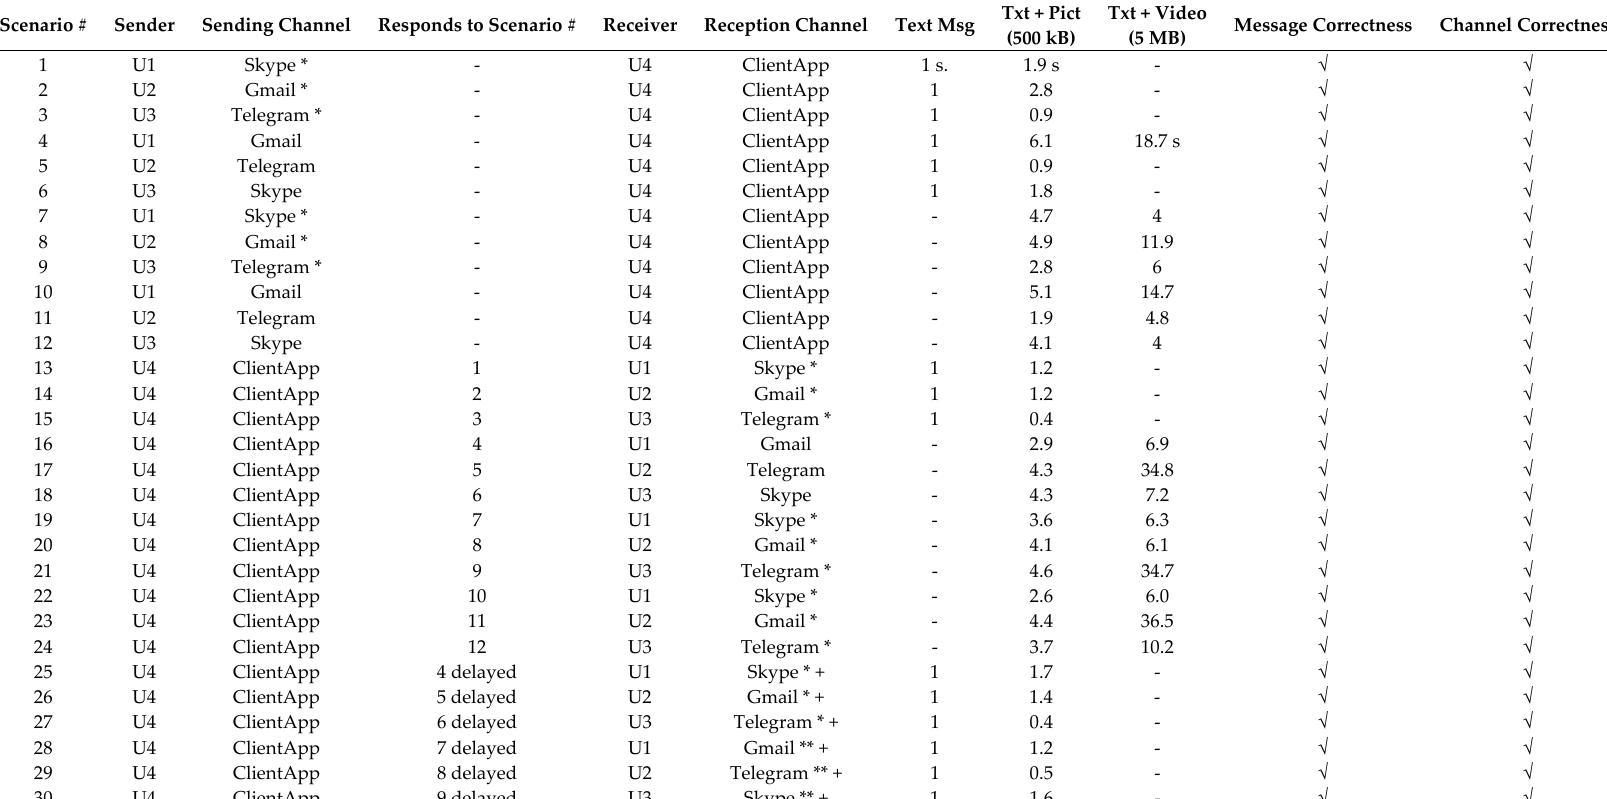
Table 1. Summary of the empirical